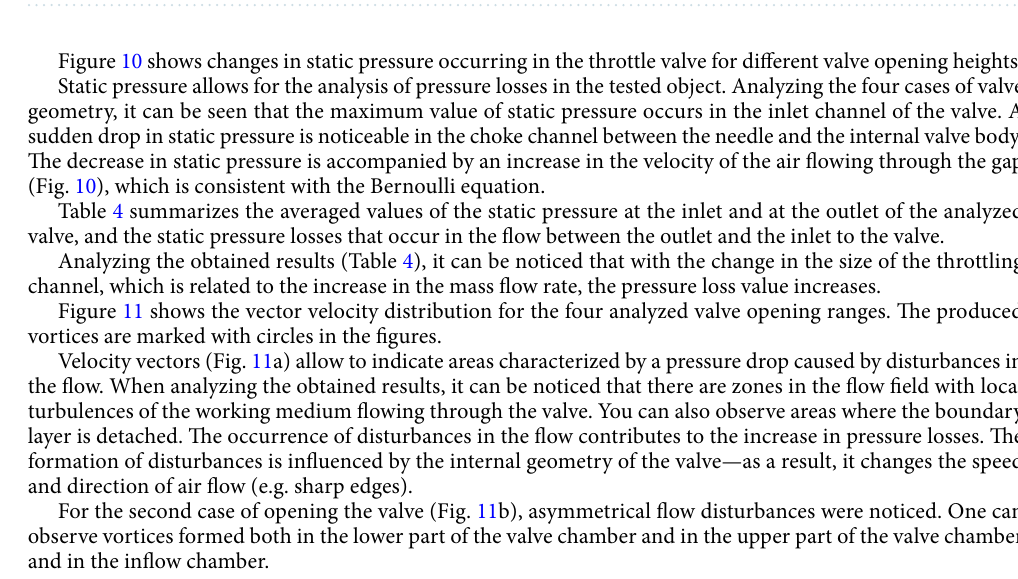
Figure 10. Static pressure for various configurations of the valve opening height. ( a ) h 1 3 m, ( d ) h 3 m, ( c ) h h 1.43 10 2.69 10 0 [Ansys Fluent 2021 R2 (ANSYS Academic Research 3 2 4 − − = × = × = Mechanical and CFD): https:// downl oad. ansys. com/ Curre nt% 20Rel ease? relea seno= 2021% 20R2& opera tings ystem= Windo ws% 20x64].